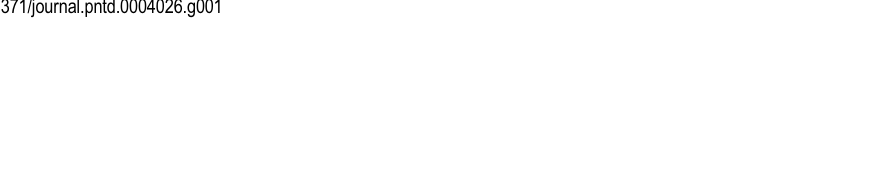
PLOS Neglected Tropical Diseases | DOI:10.1371/journal.pntd.0004026 September 24,